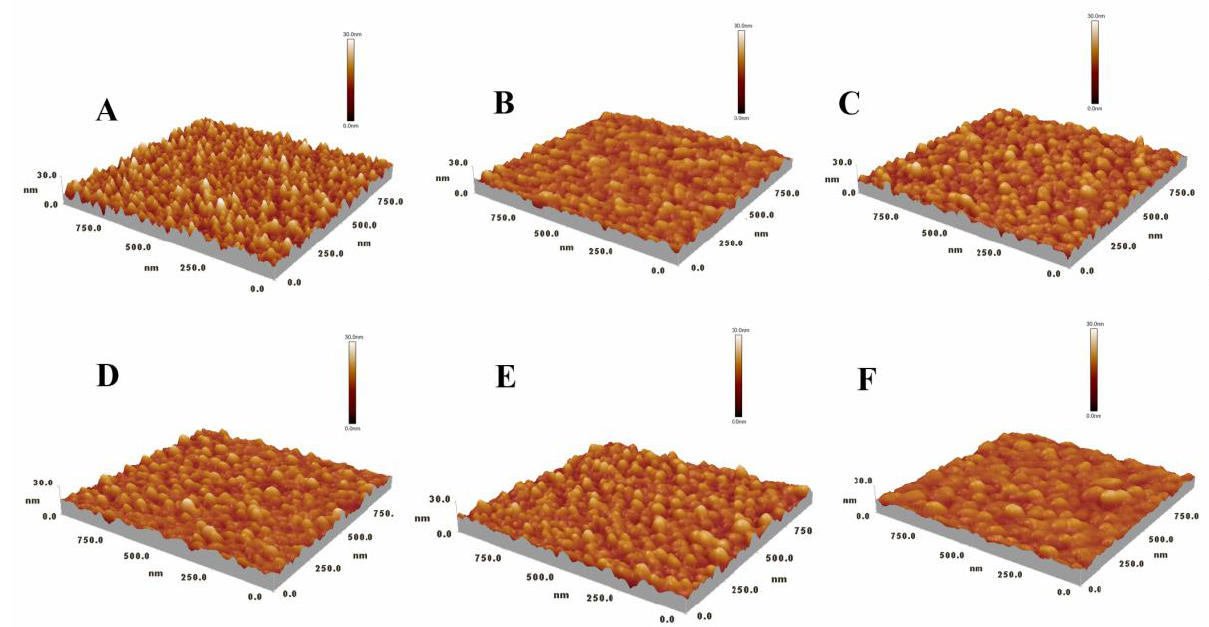
Figure 6. AFM measurements of the 3D-topography of HSA in various solutions. ( A ) The control, ( B ) imatinib, ( C ) dasatinib, ( D ) nilotinib, ( E ) bosutinib, ( F ) ponatinib. All images are of the same size and the high bar represents 30 nm.